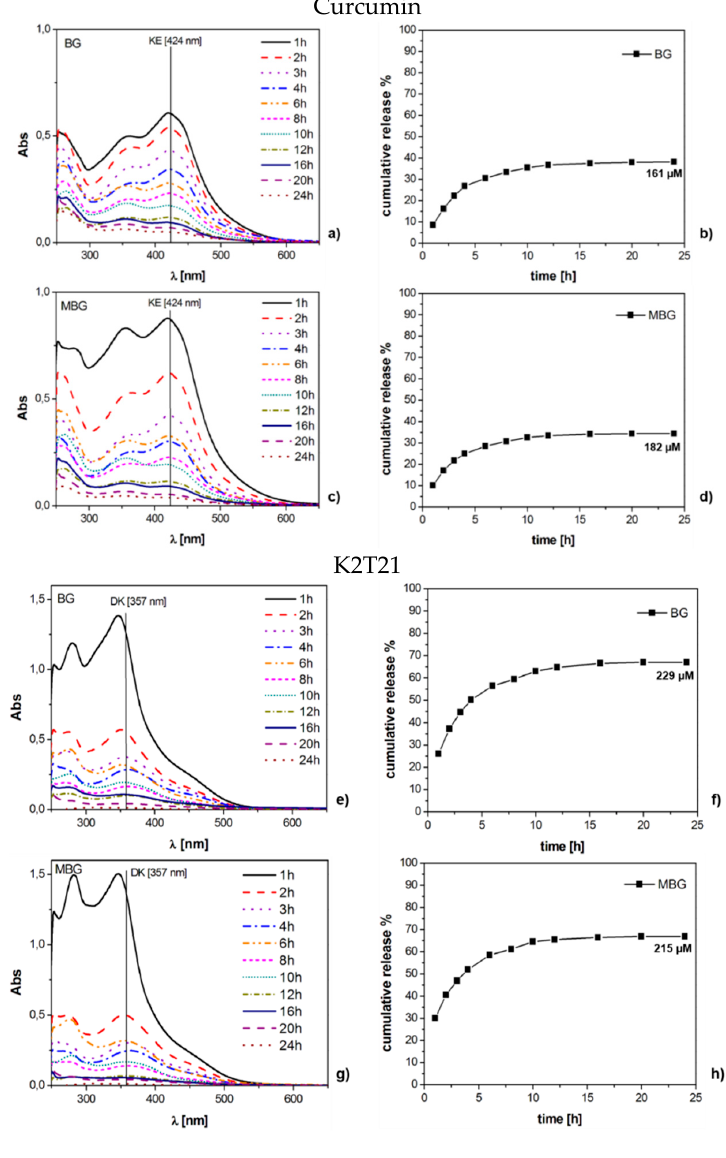
Figure 5. UV-Vis spectra and cumulative release in SBF (expressed in %) of BG and MBG samples loaded with: curcumin ( a – d ); and K2T21 ( e – h ).